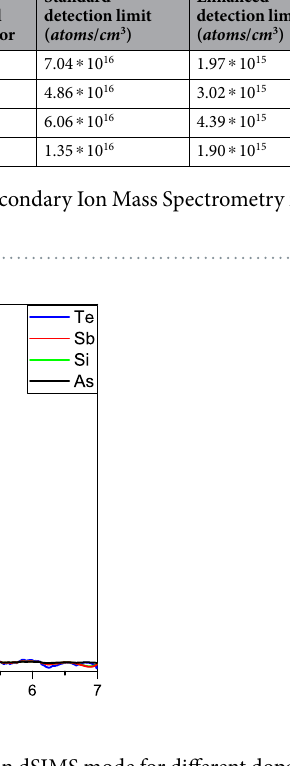
Figure 3. The gain change during sputtering in dSIMS mode for different dopant types in various substrates. At the beginning the blocking effect is very strong but after the partial destruction of graphene it is reduced and the enhanced ionization probability is dominant. Thus the gain is much larger than a factor of 1. After the complete destruction of the graphene layer, no difference between the two samples is observed ( GF = 1). The shape of all curves and the position of the maximum depends on the partial destruction of the graphene layer and thus are similar for all